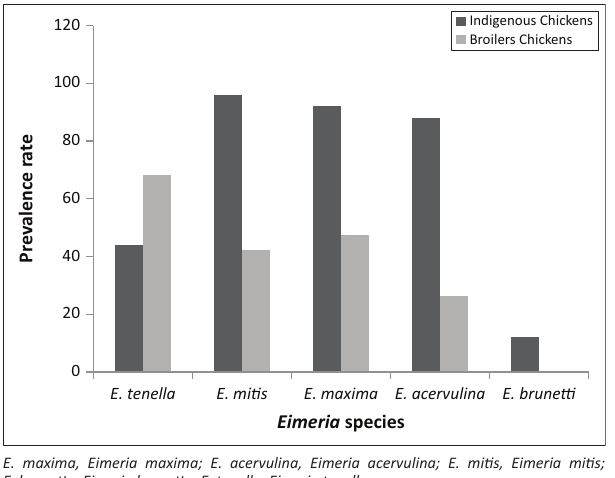
FIGURE 4: Prevalence of Eimeria species in both broilers and free-range chickens in KwaZulu-Natal.